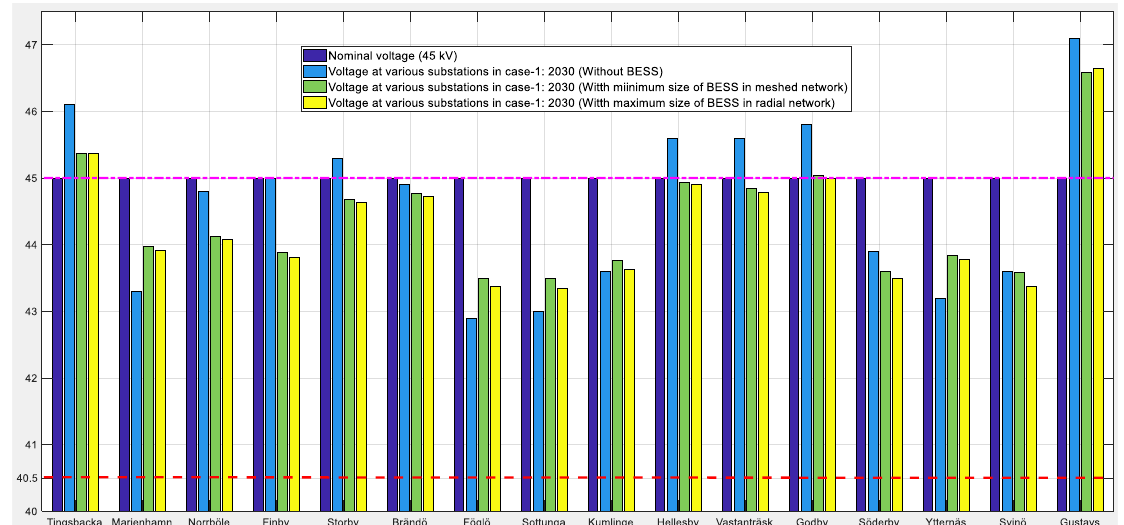
Figure 16. Meshed mode operation of the electricity network in the Å land Islands for the year 2030 with BESSs.